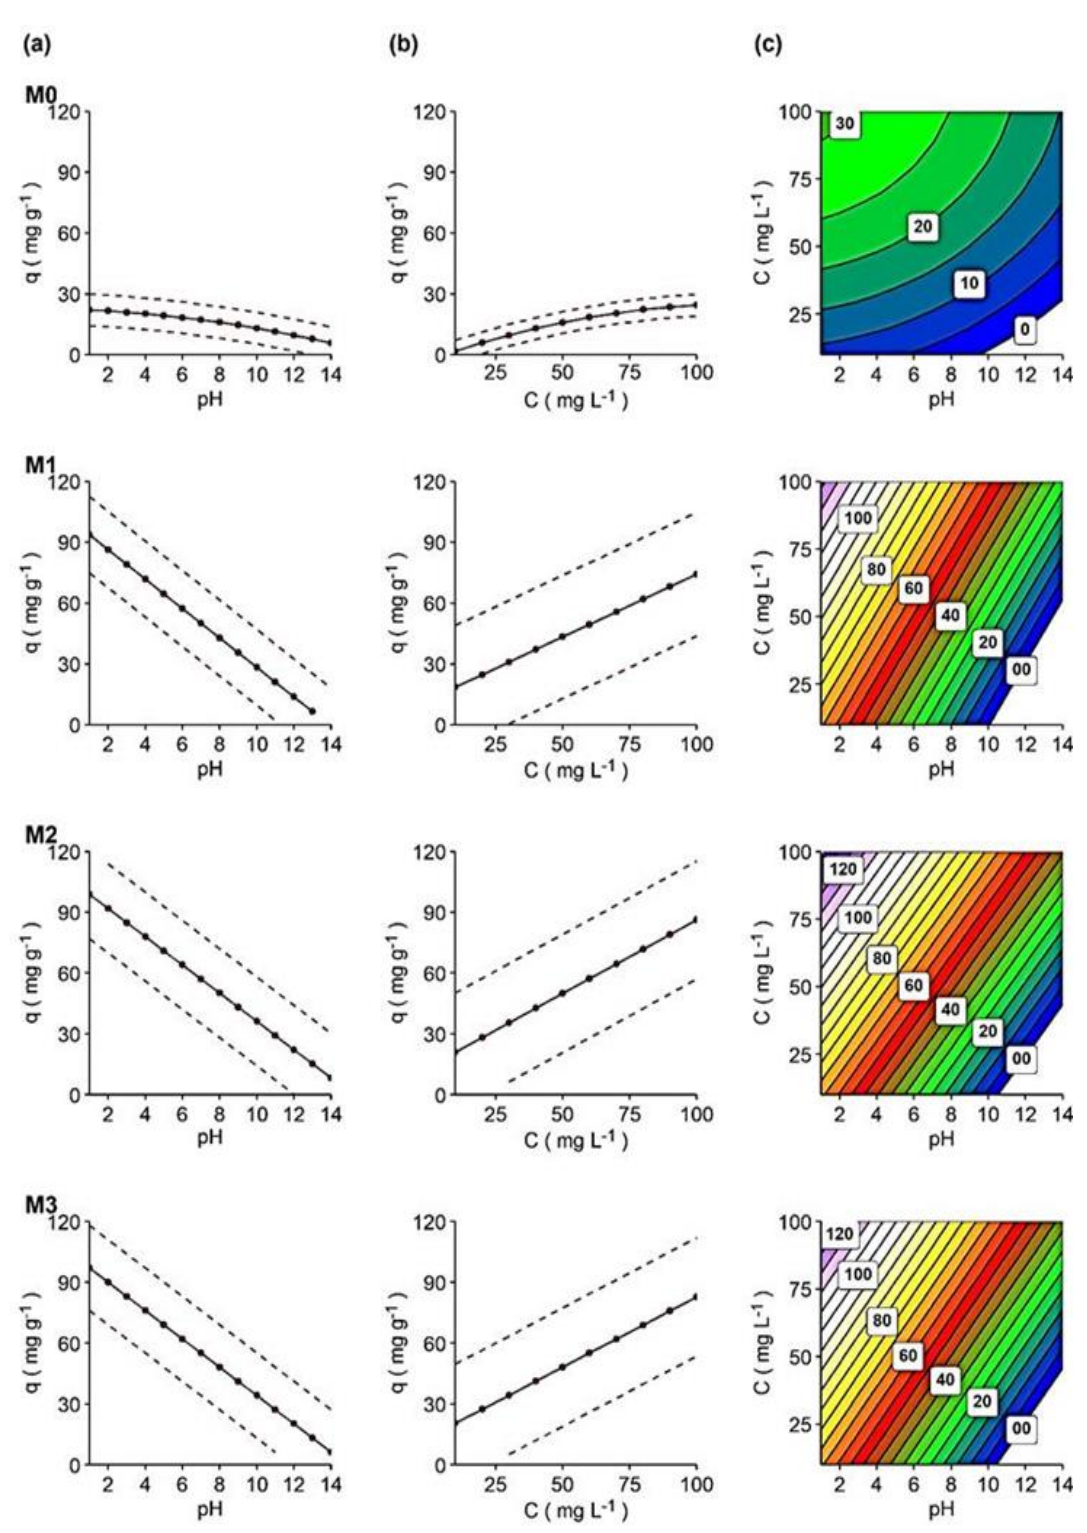
Figure 6. ( a ) pH’s effect on adsorption capacity, regardless of dye concentration (dots are the predicted mean response for those pH values (from 1 to 14), while the dotted line is the standard deviation range), ( b ) dye concentrations’ effect on adsorption capacity, regardless of pH value, at t = 120 min (dots are the predicted mean response for dye’s concentrations (from 10 to 100 mg L − 1 , every 10), while the dotted line is the standard deviation range of the response) and ( c ) contour graphs for adsorption capacity of each membrane in relation to pH and dye concentration.